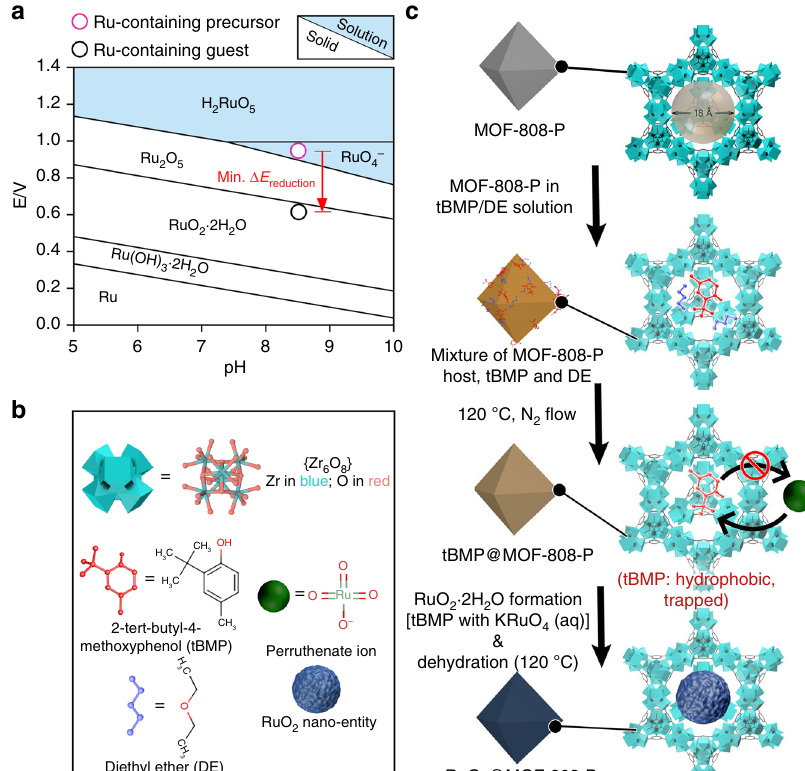
Fig. 1 Pourbaix enabled guest synthesis (PEGS) strategy for RuO 2 incorporation into MOF-808-P. a Pourbaix (redox potential-pH) diagram for Ru-H 2 O system (with a pH range of 5 – 10; concentration of Ru-based solution = 20 mM) constructed based on previously available data versus standard hydrogen electrode (SHE) 29 . Within the pH range it shows the range of potentials where a certain phase is thermodynamically stable, and the potential needed to transform one phase to another, i.e., the red arrow shows that to transform a soluble Ru-based precursor, perruthenate ion (RuO 4 − ), to solid Ru-based guest (i.e., RuO 2 · 2H 2 O) at a pH of ca. 8.5 (20 mM aqueous potassium perruthenate (KRuO 4 )), one needs minimum reduction potential ( Δ E reduction ) of 0.3 – 0.4 V (assuming an unaltered pH). A reductant, such as 2-tert-butyl-4-methylphenol (tBMP) with expected ca. 0.3 V to be oxidized, could be suitable. Diethyl ether (DE) is used as a solvent for tBMP. b Symbols for the scheme in ( c ), which illustrates RuO 2 synthesis inside the cavity of pre-formed MOF- 808-P using the hydrophobic reducing lipid tBMP. For clarity (i) the schematics of MOF-808-P is simpli fi ed as standard MOF-808 36 and (ii) hydrogen atoms and carbon atoms for formates (HCOO − ) are omitted in the metal – organic framework (MOF)